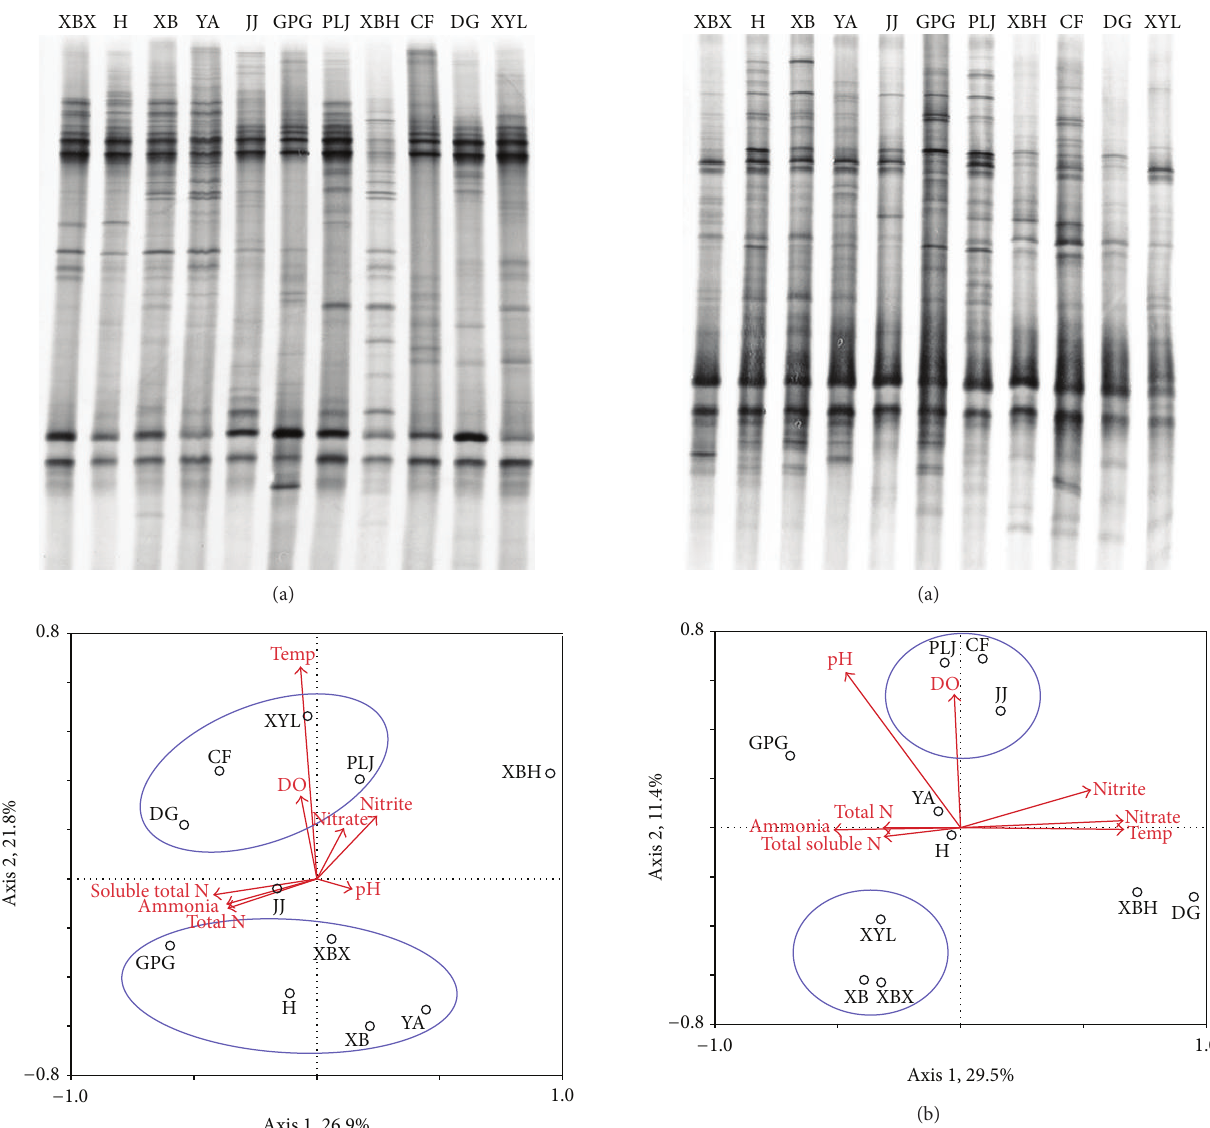
Figure5:DGGEfingerprintsandtheredundancyanalysisofDGGE band data of nirS gene. Arrows represent quantitative variables of environmental variables and small circles with letters represent the name of sample rivers; river names: XBX = Xinbaoxiang, DG = Daguang, CF = Chuangfang, PLJ = Panlongjiang, H = Haiheriver, GPG = Guangpugou, JJ = Jinjia, XBH = Xibahe, XYL = Xinyunling, XB = Xiaba, and YA =